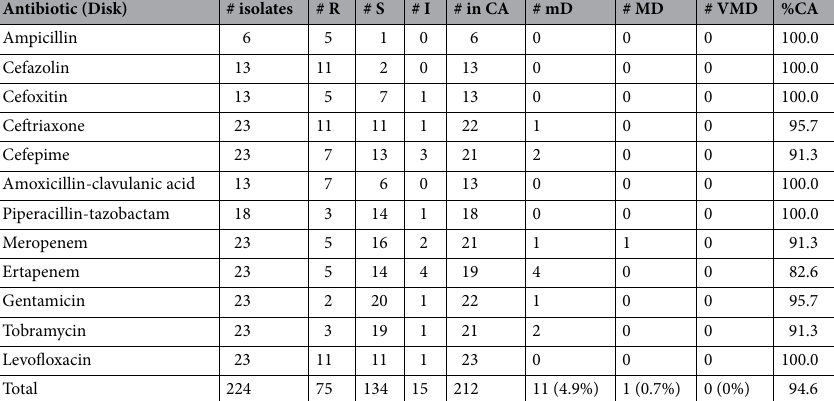
Table 2. Disk diffusion antimicrobial susceptibility results for the eMcF compared to the traditional 0.5 McF. Results for 23 Gram-negative isolates comprising seven species, E. coli (6), E. cloacae (2), K. pneumoniae